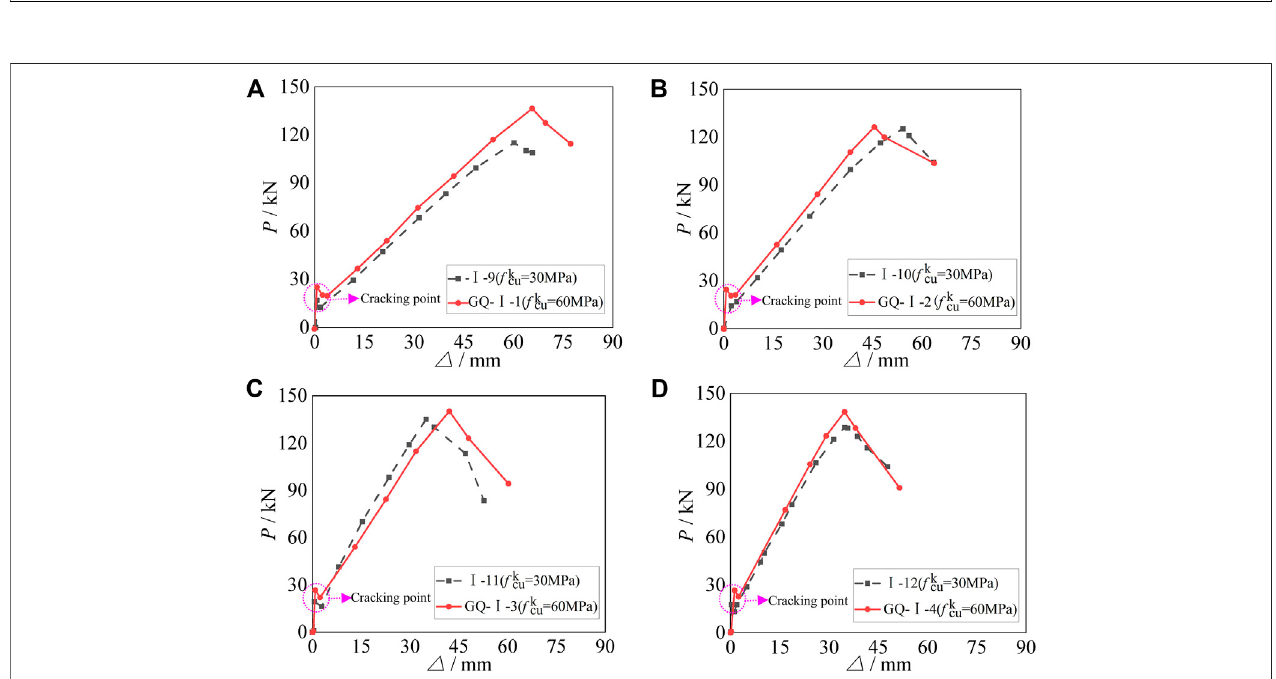
FIGURE13| Comparisonofload – displacementcurvesofGFRPsimplysupportedbeamsconsistingofgradientconcreteandHSC: (A) ρ GFRP (cid:2) 1.14%; (B) ρ GFRP (cid:2) 1.49%; (C) ρ GFRP (cid:2) 1.88%; (D) ρ GFRP (cid:2) 2.33%.